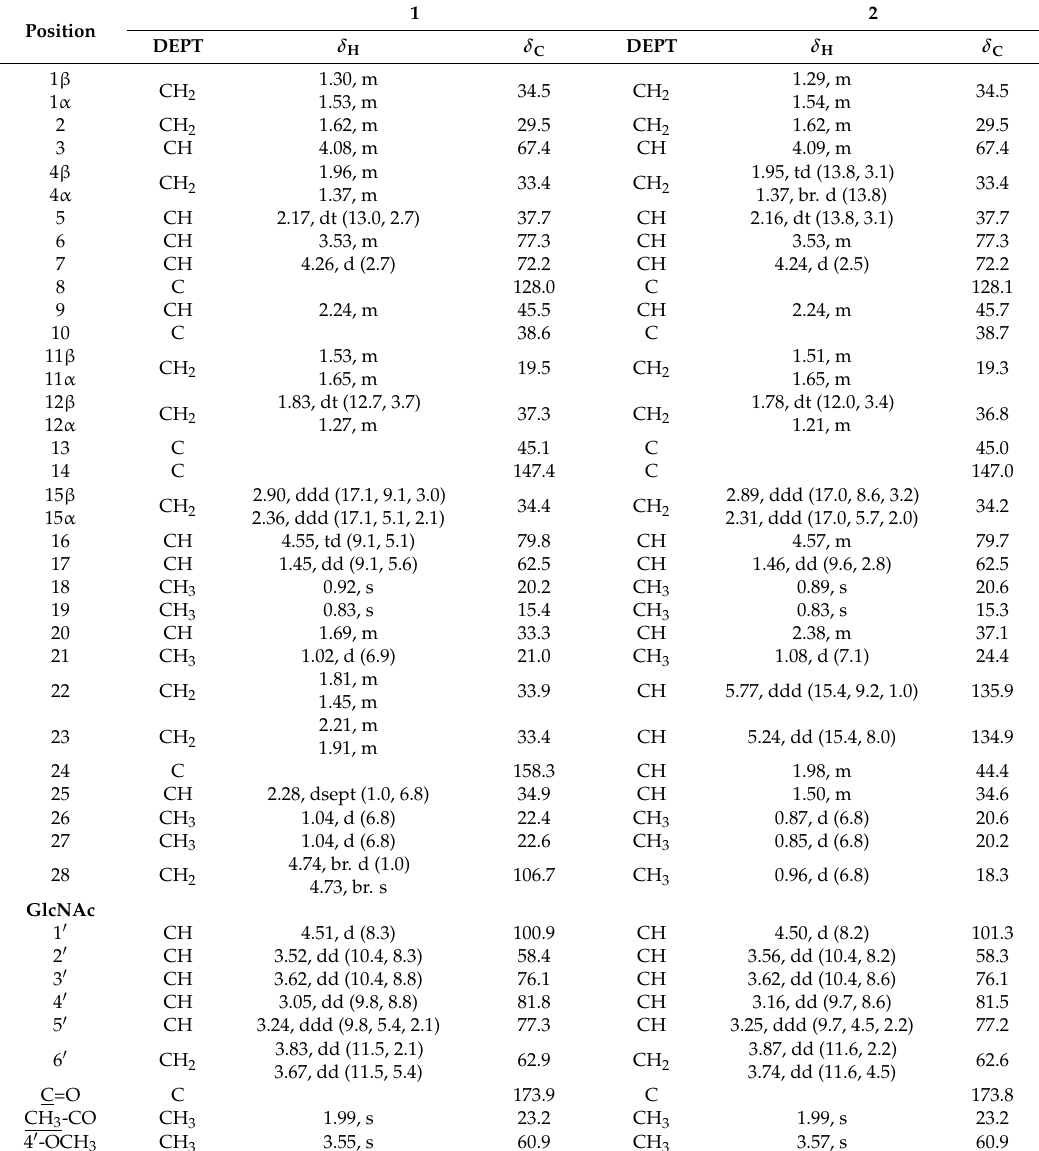
Table 1. 1 H (700.13 MHz) and 13 C (176.04 MHz) NMR chemical shifts of 1 and 2 in CD 3 OD, at 30 ◦ C, δ in ppm, J values in